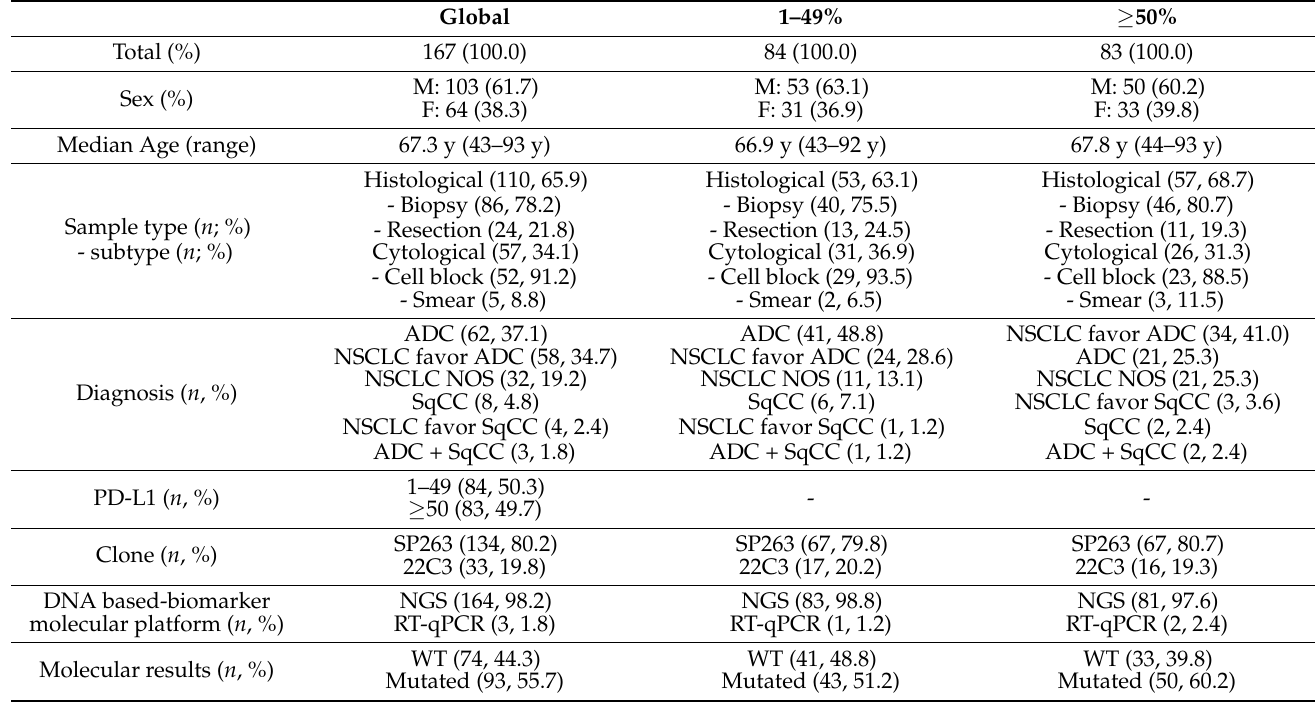
Table 1. Clinical and molecular findings of the study population.